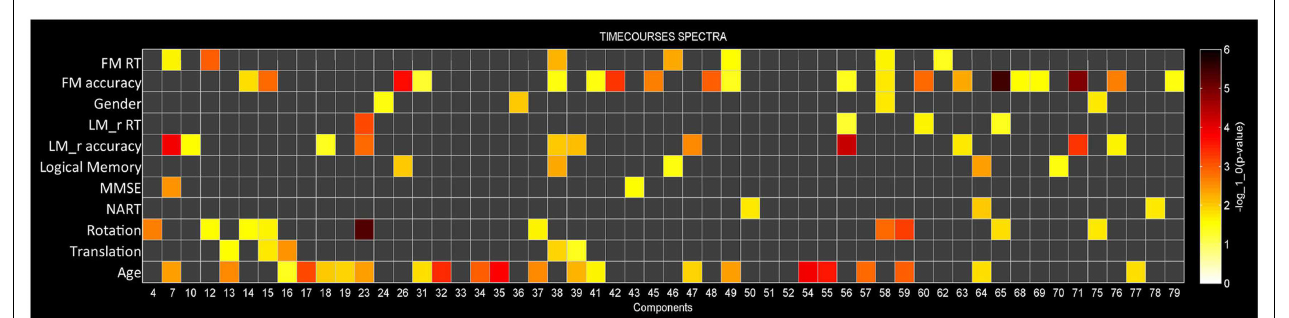
FIGURE 3 | Multivariate statistics . Results from the reduced mancova models, depicting the significance of covariates of interest and nuisance predictors for power spectra in log 10 ( p ) units. Gray cells indicate terms that were removed from the full model during backward selection